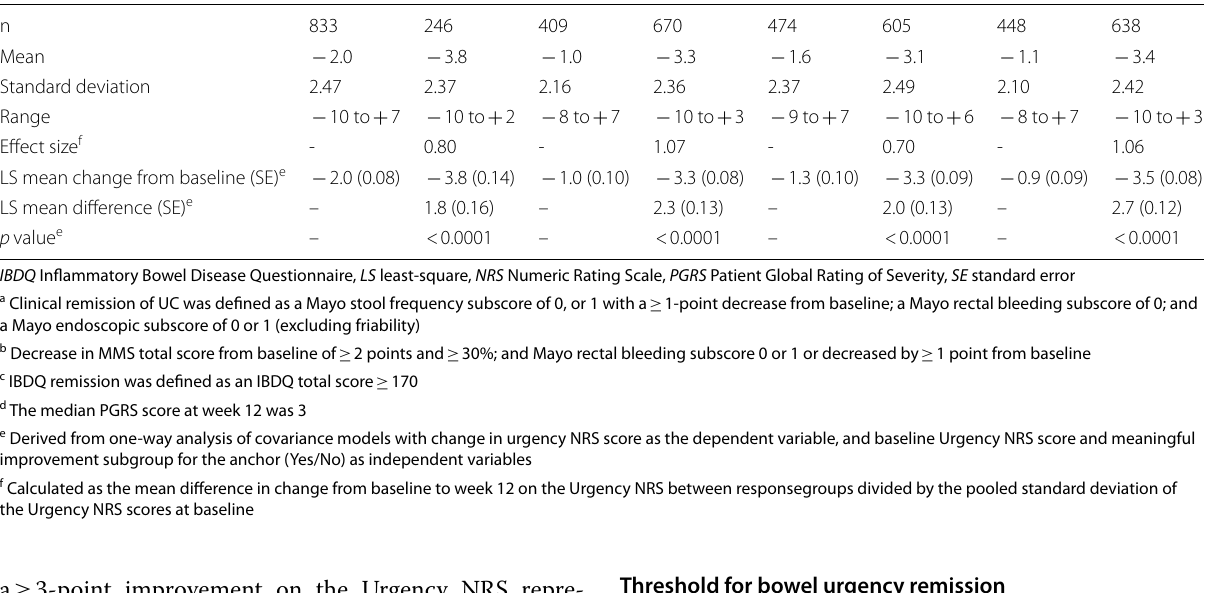
Rectal bleeding